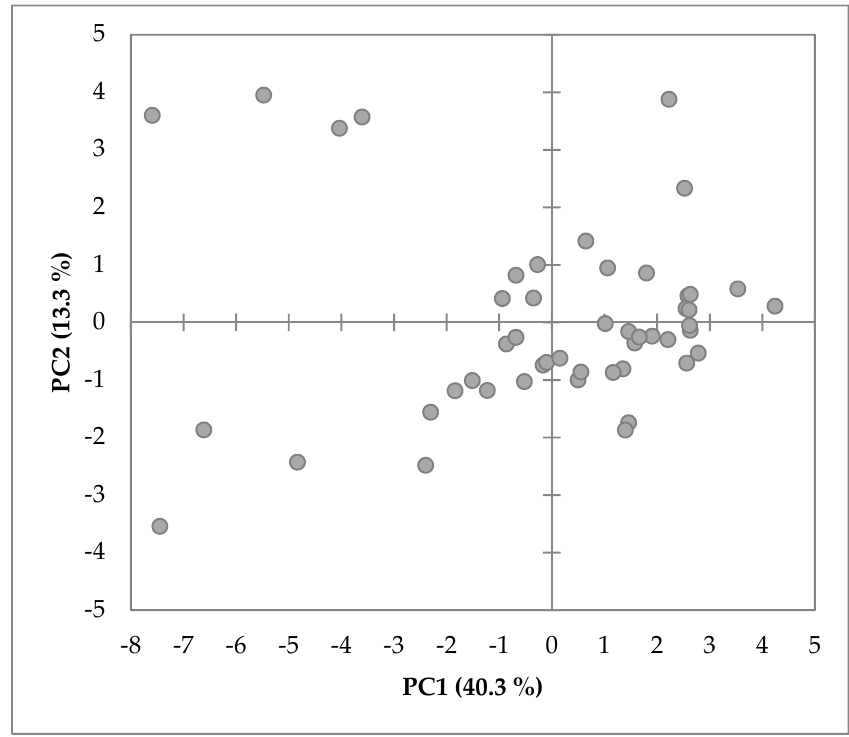
Figure 2. Two-dimensional loading plot of the PCA showing the distribution of the individual farm results of all 49 farms for PC1 and PC2.